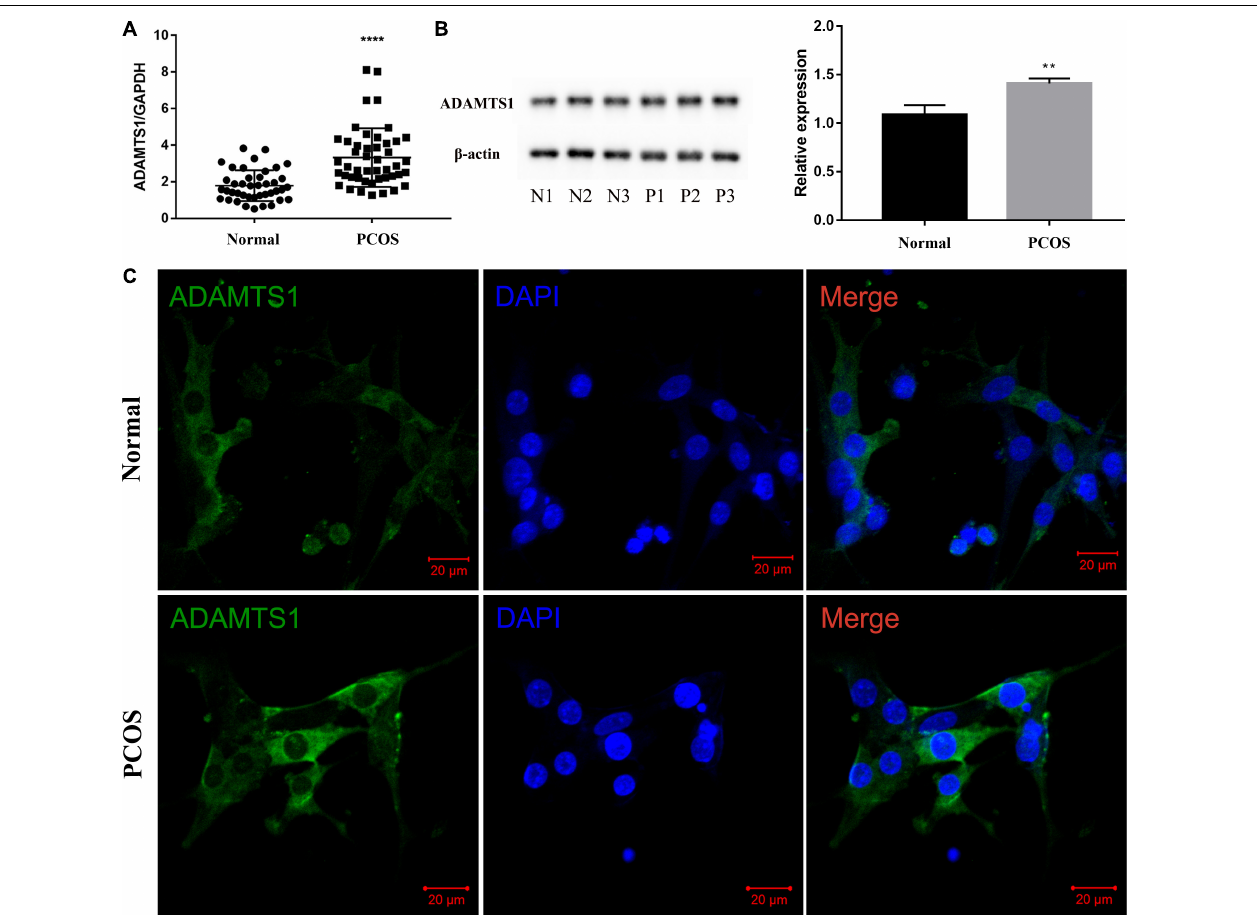
FIGURE 1 | ADAMTS1 is up-regulated in granulosa cells of PCOS patients. Real-time PCR analysis of ADAMTS1 mRNA expression in primary granulosa cells from control and PCOS patients (A) . GAPDH was used as an internal control. **** Indicates p < 0.0001. The protein levels of ADAMTS1 detected by western blot in primary granulosa cells were from control and PCOS patients (B) . The immunofluorescence staining was used to detect the expression and localization of ADAMTS1 in granulosa cells of ovulatory controls and PCOS patients (C) . Green, ADAMTS1. Blue, DAPI indicates the nuclear localization signal. Bar = 20 µ m.